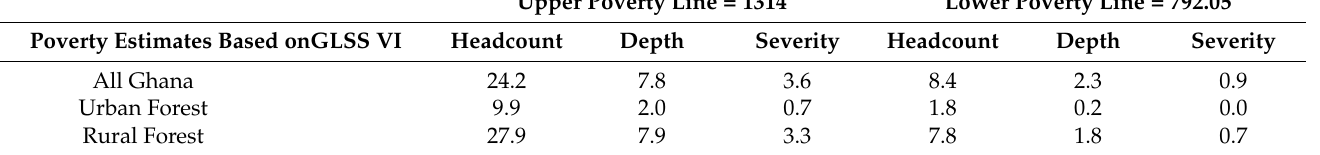
Sources: Ghana Living standard survey